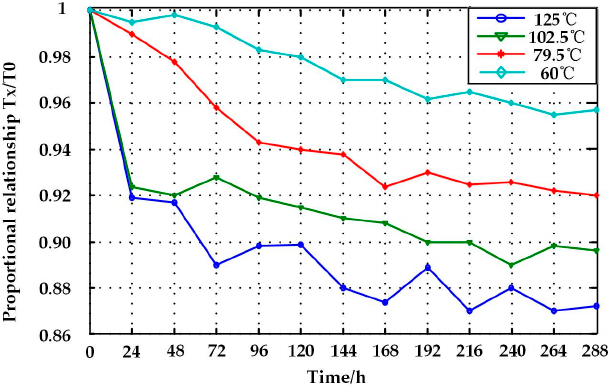
Figure 9. The test values of closing time.